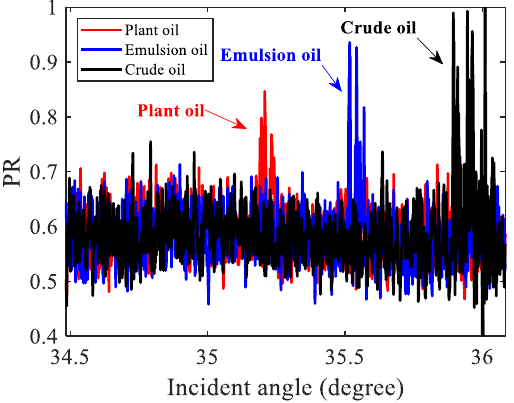
Figure 7. The co-polarization ratio extracted from the three white lines in Figure